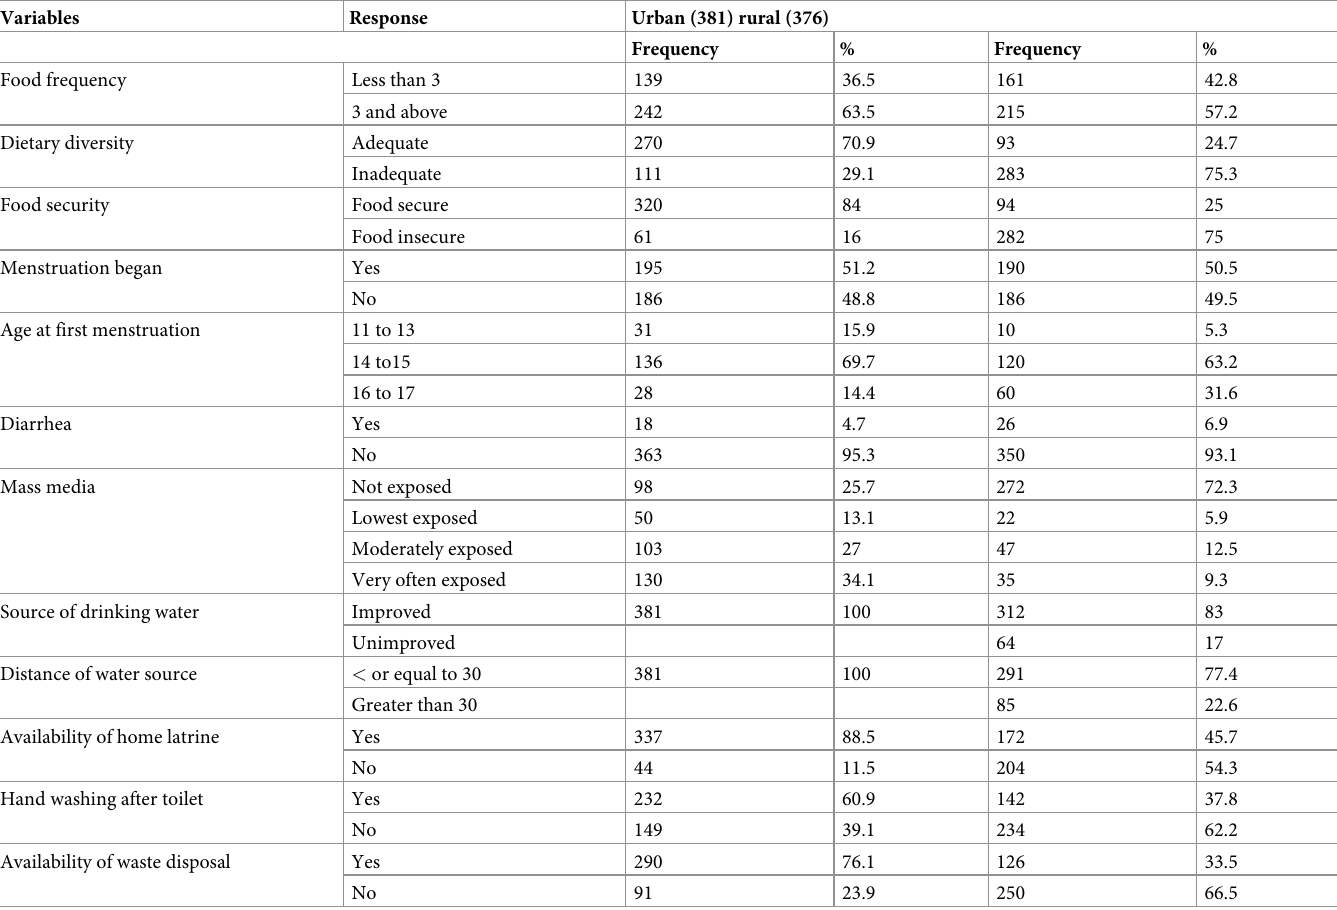
Table 2. Nutritional, health-related, and environmental characteristics among school adolescent girls in Debark district, 2020 (n = 757).